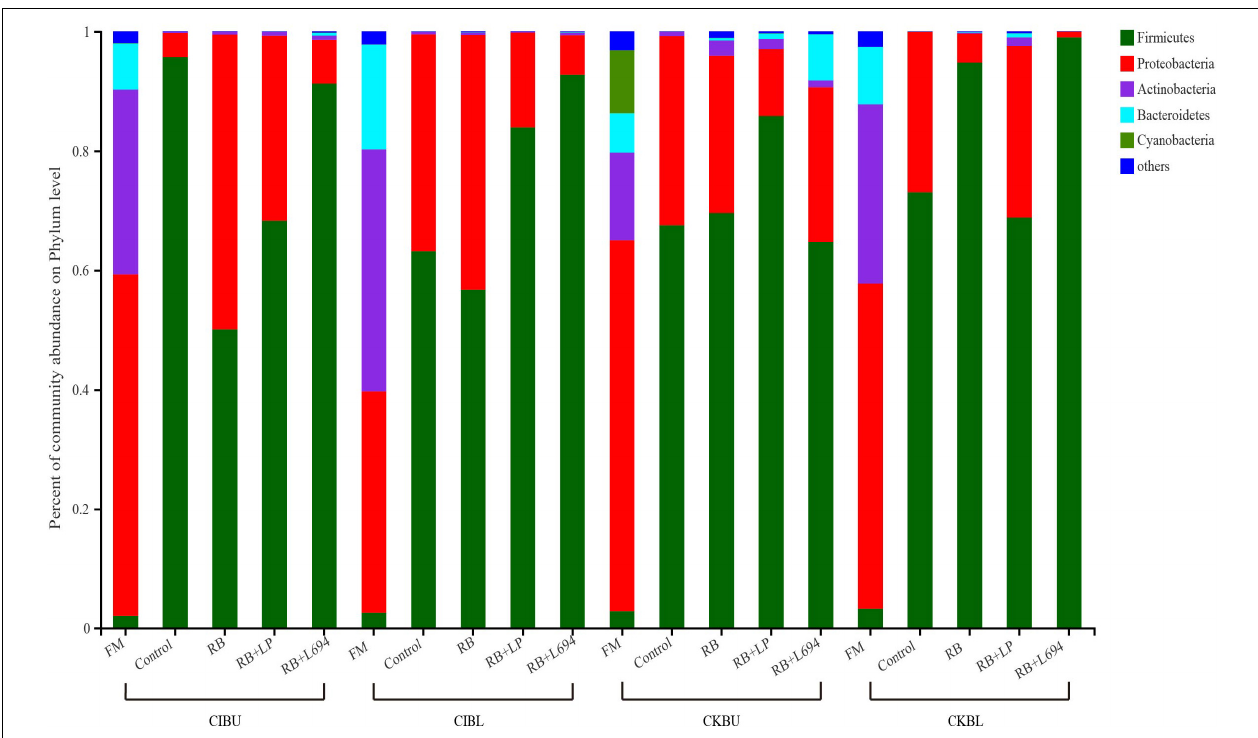
FIGURE 4 | Bacterial communities and relative abundance of Caragana materials and their silages at phylum level ( n = 3).